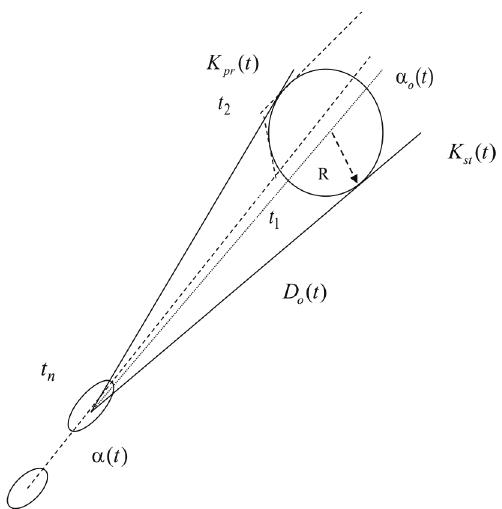
Fig. 1. The case of taking into account point navigational danger